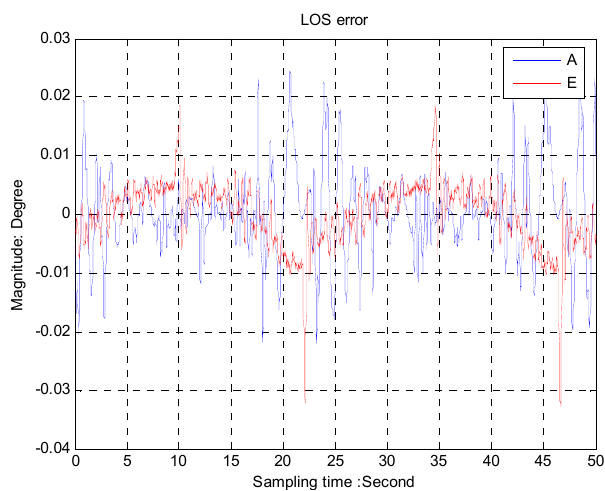
Figure 11. The LOS error with feed forward control. Sensors 2016 , 16 , 968